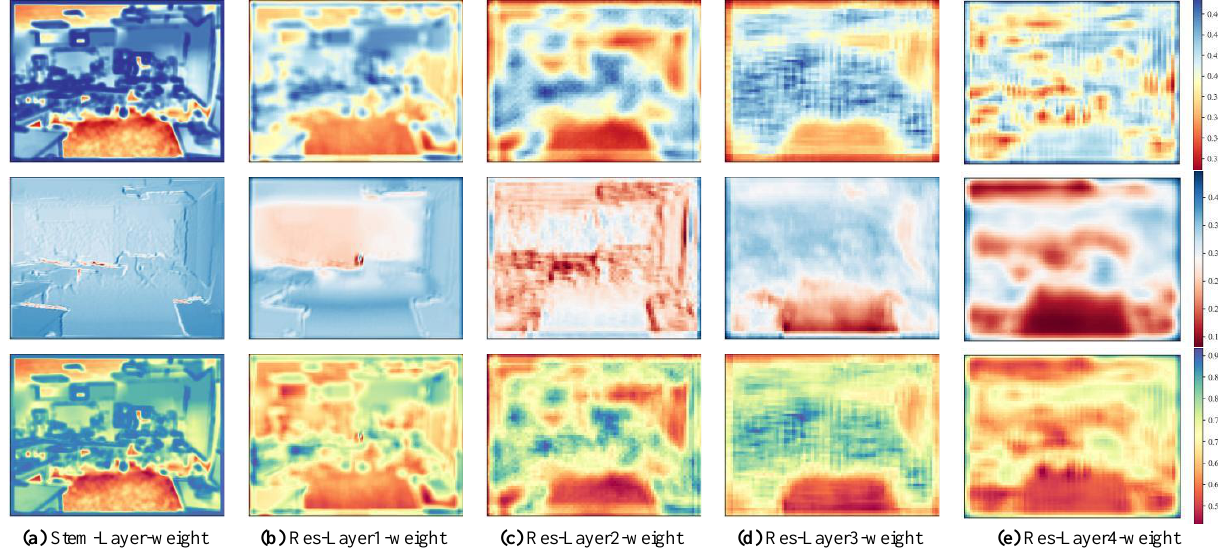
Figure 10. Weight Map of Spatial Attention Module in Different